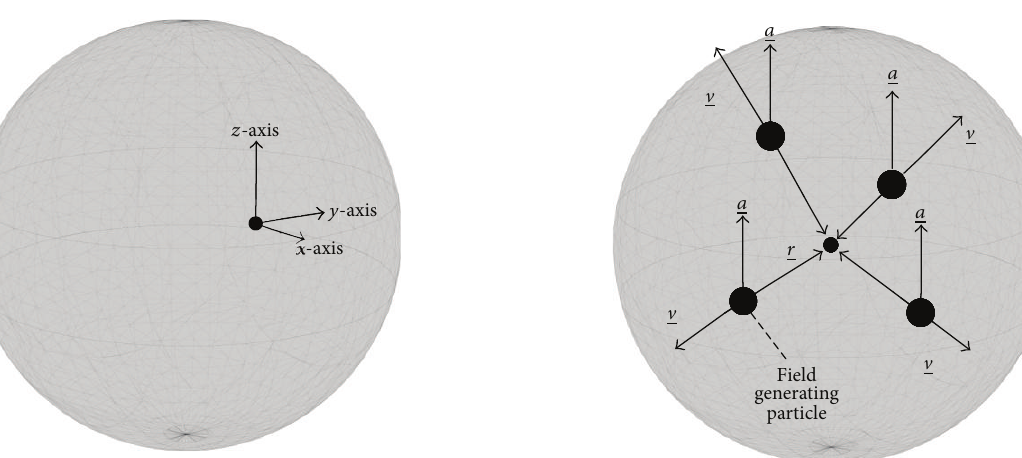
Figure 6: Hubble expansion of the universe. Particles move away from the observer in the center, in radial